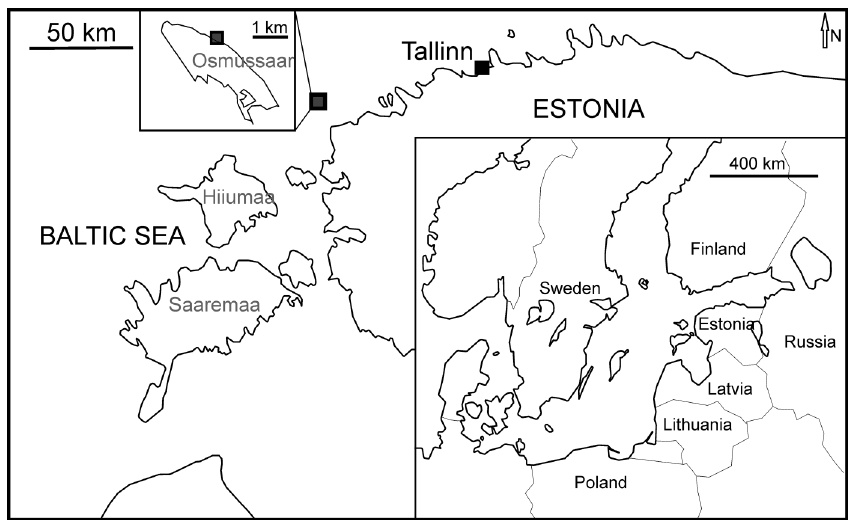
Fig. 1. Location of Osmussaar Island and locality of Oikobesalon